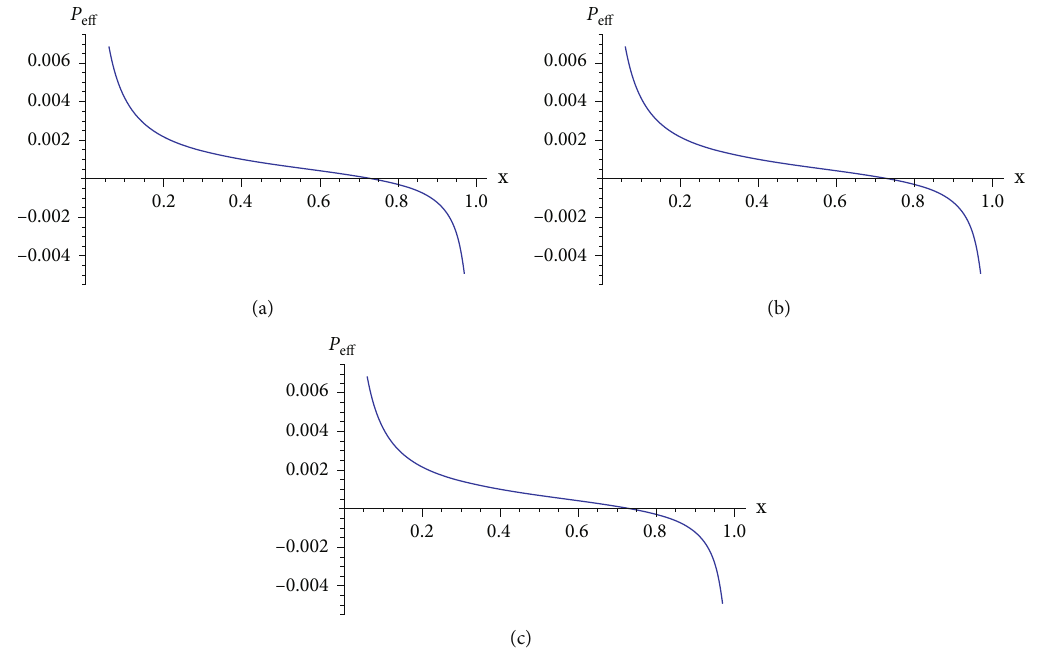
− x curves with l 2 = 100 , and (a) for ϕ 2 ef f